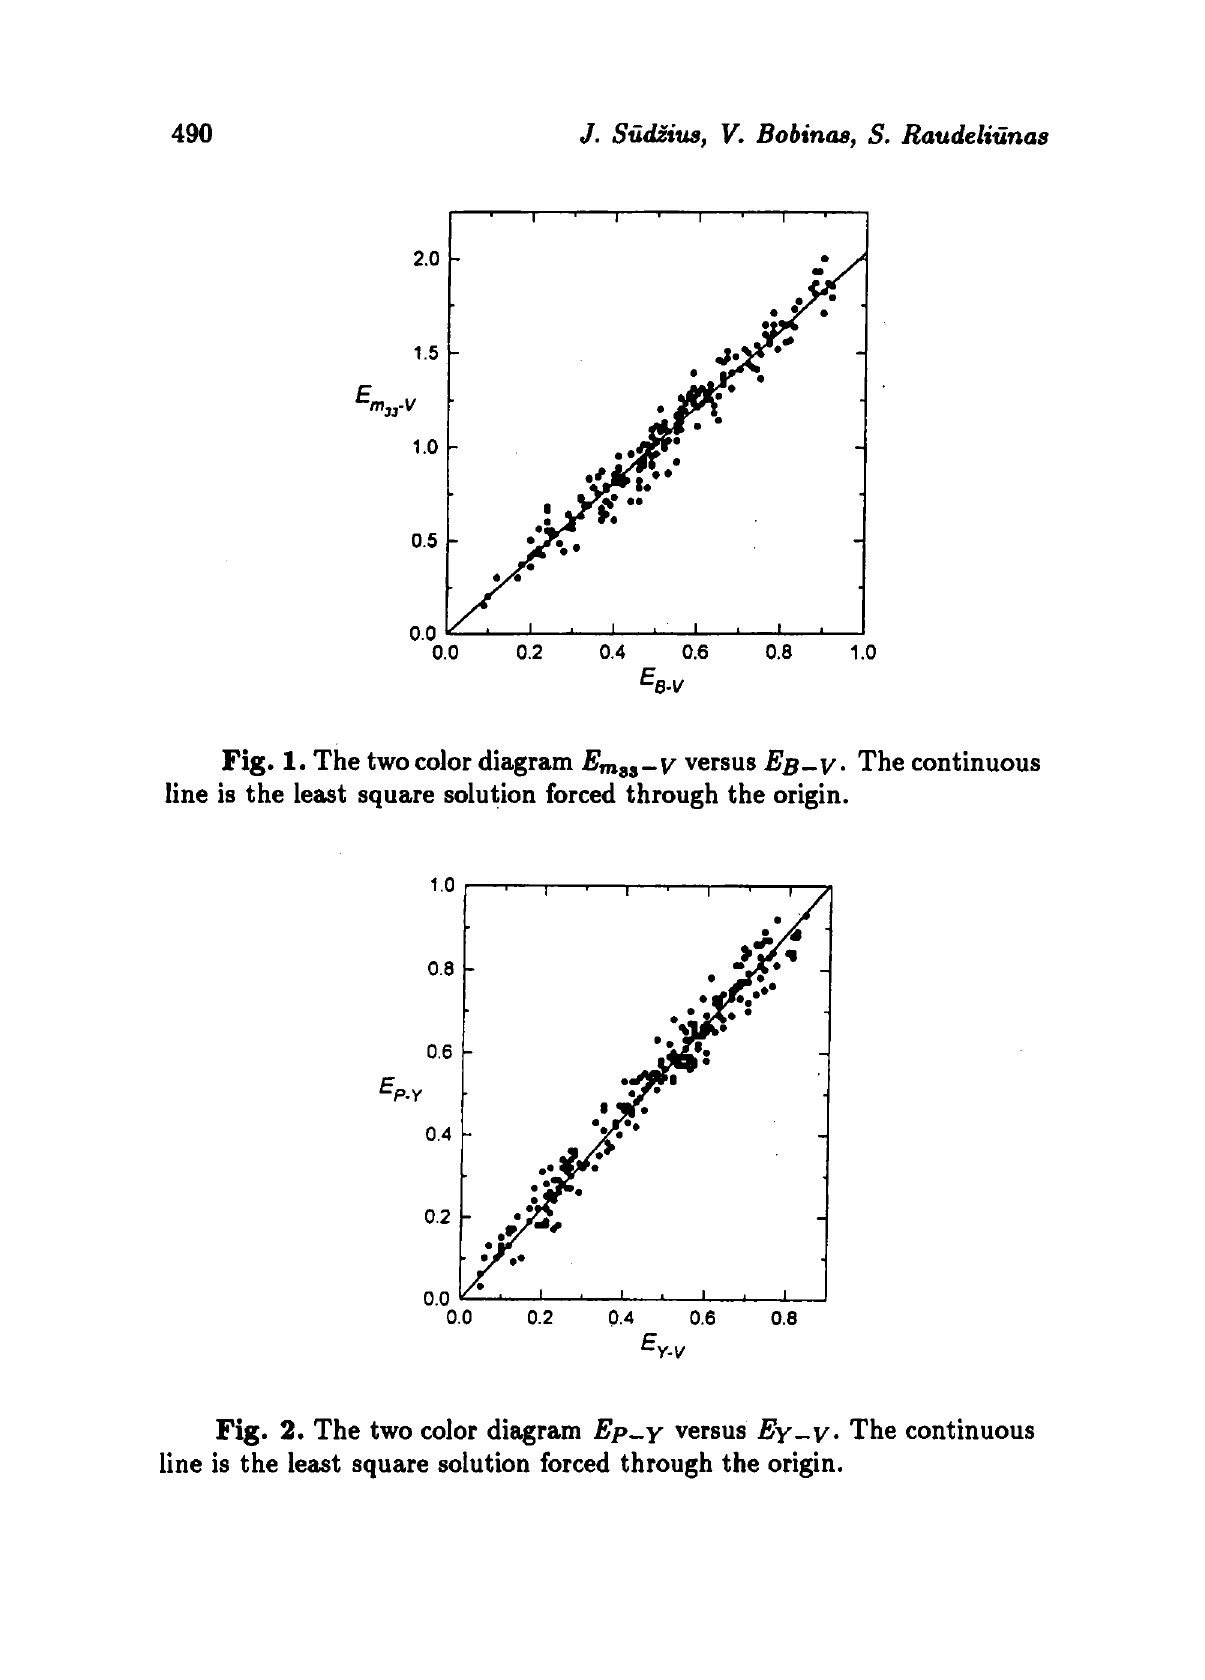
Εγ.ν Fig. 2. The two color diagram Ερ-γ versus Εγ-ν · The continuous line is the least square solution forced through the